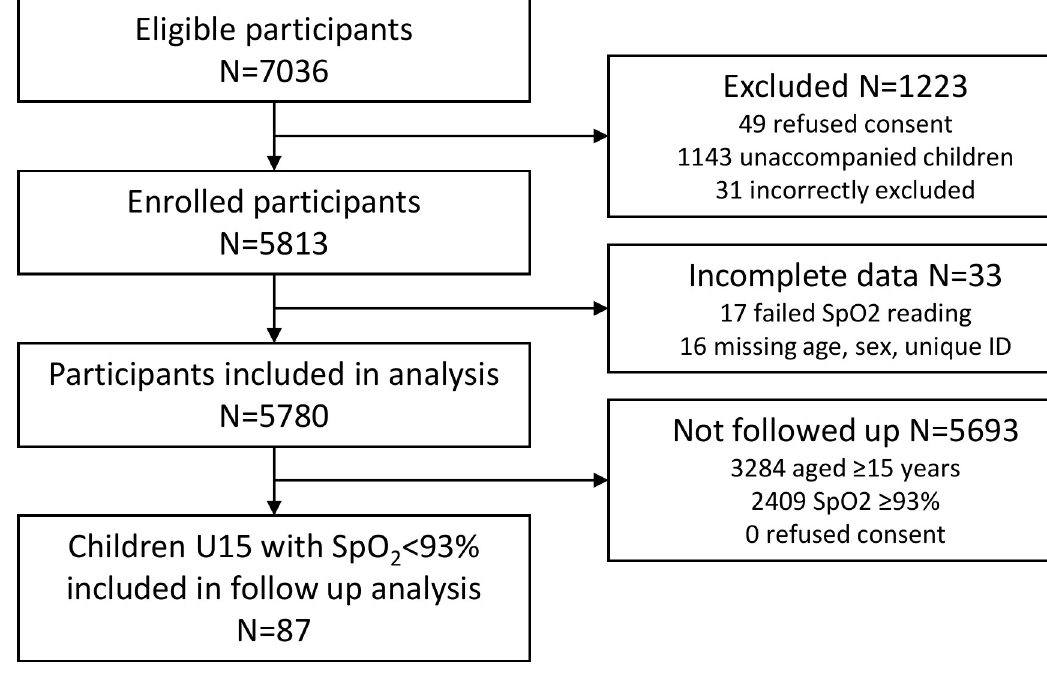
Fig 1. Participant flow chart.